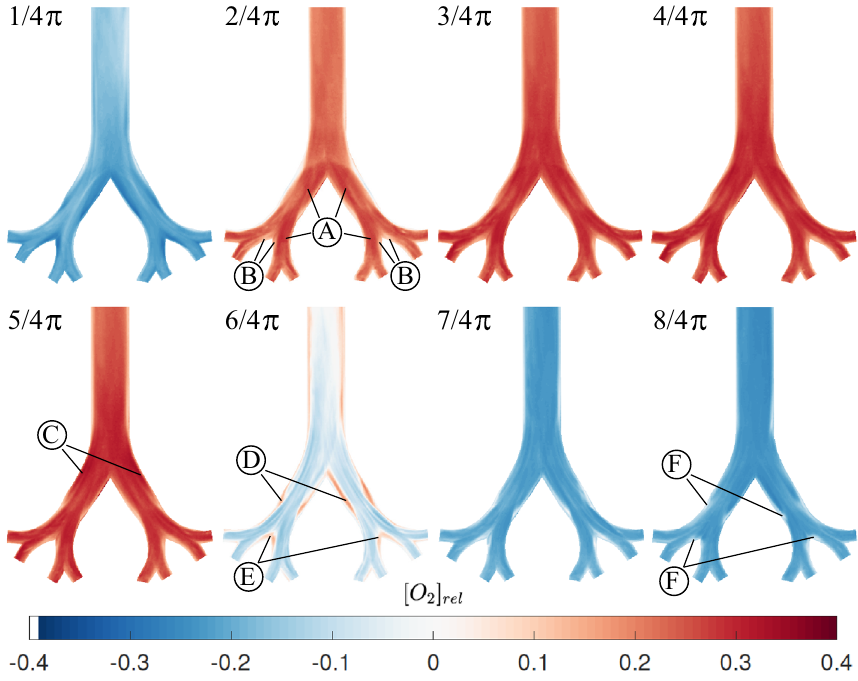
Figure 2. Time-series of the phase averaged, relative oxygen concentration at selected phase angles during one cycle at a tidal volume of 60 ml and a frequency of 0.05 Hz ( Re 0 = 1145